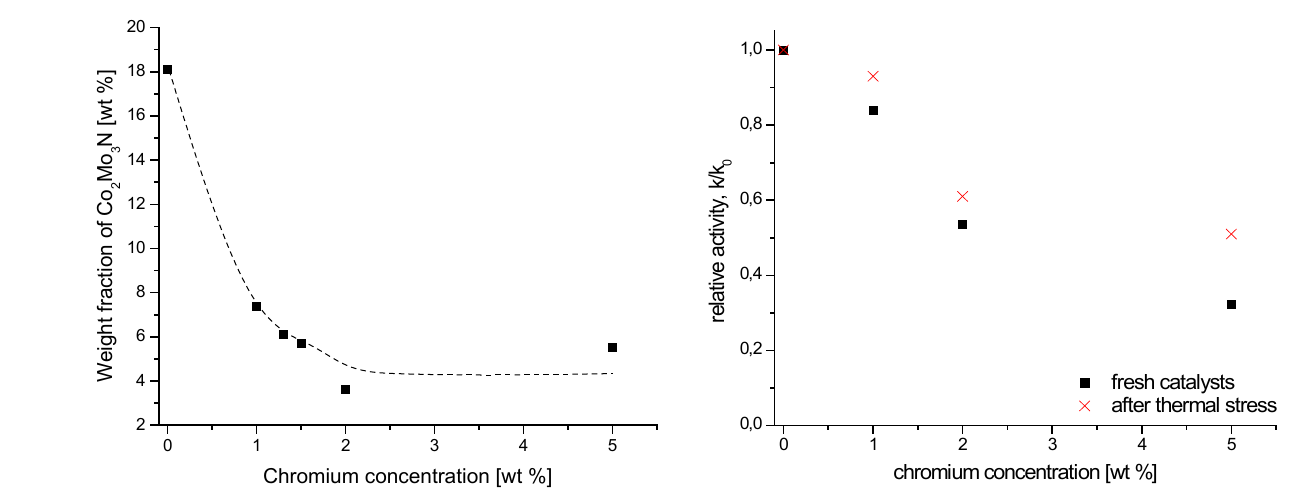
Mo N phase calculated upon XRD 2 3